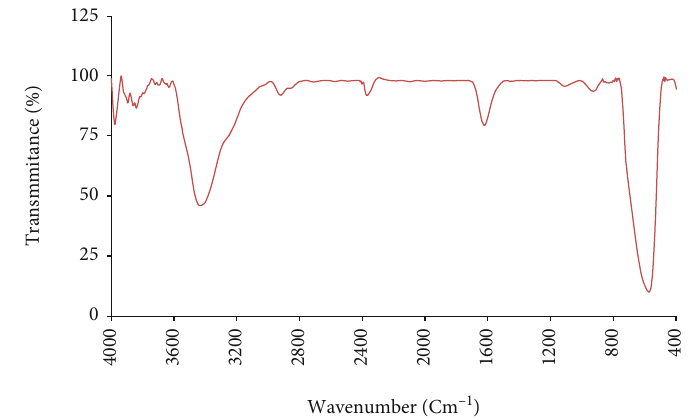
Figure 4: FT-IR spectrum of Fe